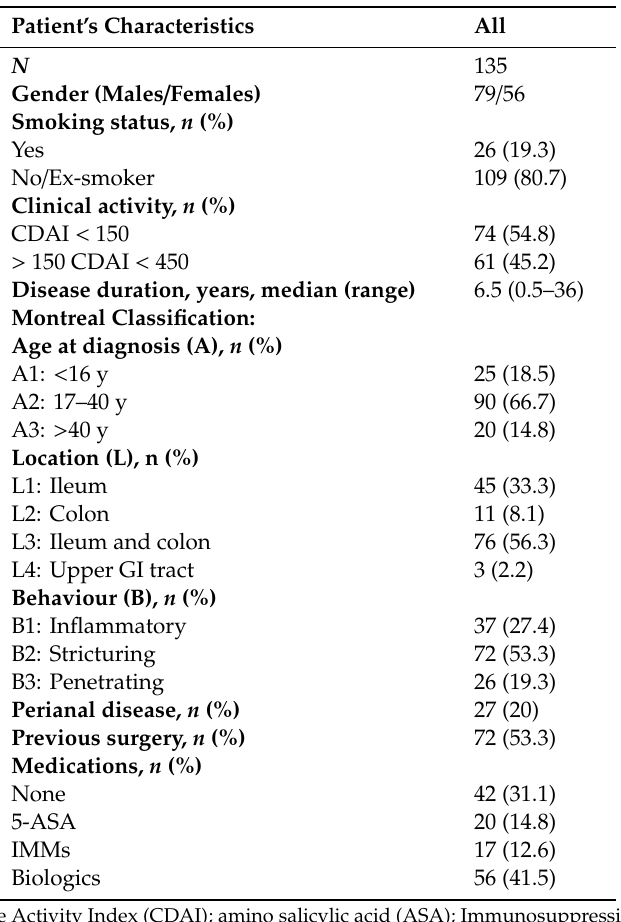
Table 1. Demographic and clinical characteristics of patients.